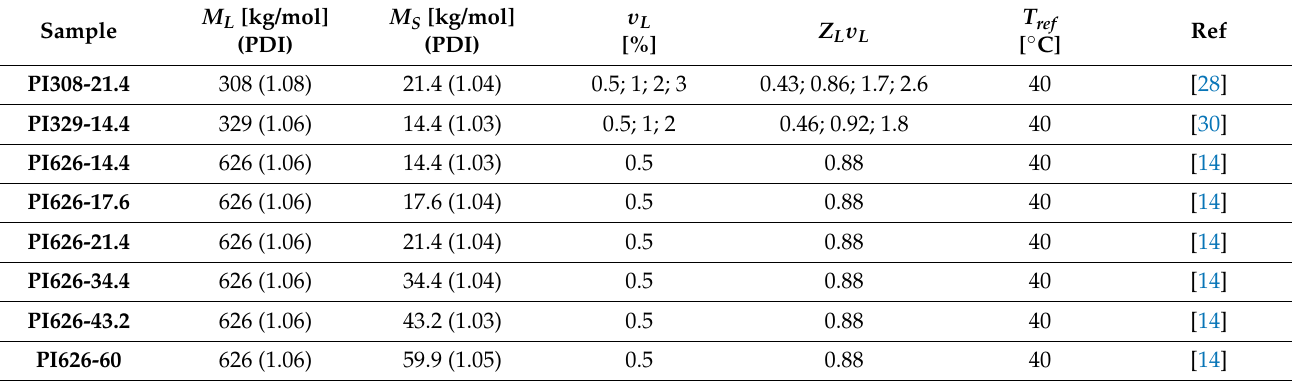
Table 4. Bidisperse PI samples.